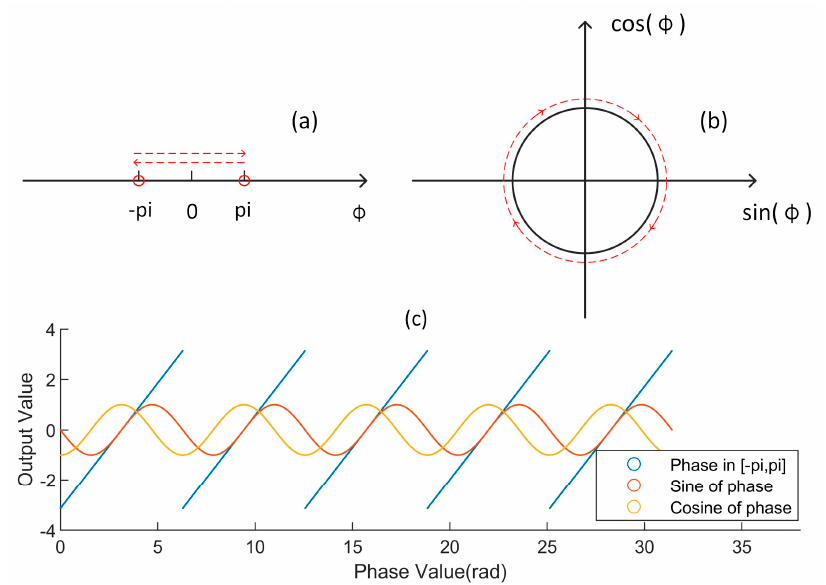
Figure 2. Comparison of the continuity of different output modes. ( a ) Change of phase; ( b ) Change of sine and cosine of phase; ( c ) Comparison of changes.